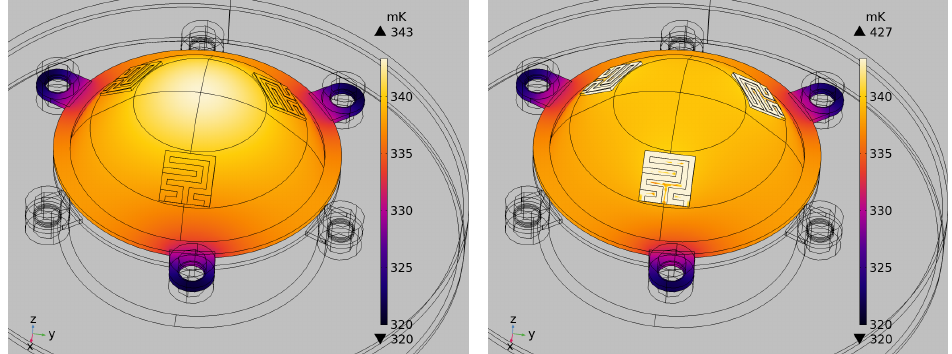
Figure 9. Temperature distribution in the whole cavity, with simulated Earth’s radiation by optical heating ( left ) and by electrical heating ( right ), with the same power of 7 mW.